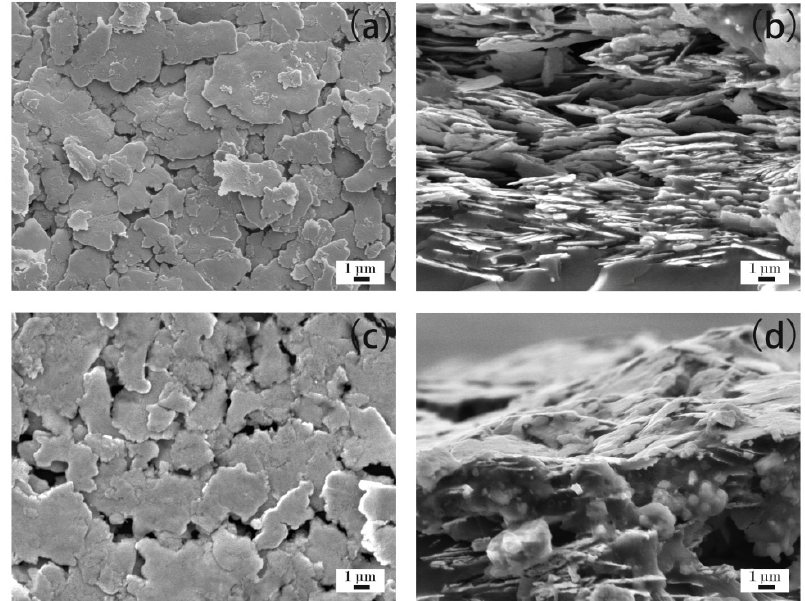
Figure 8. ECAs filled with 60 wt % Ag flakes. ( a ) ECAs fabricated by the powder spraying process; and ( b ) cross sections of ECAs fabricated by the powder spraying process; ( c ) ECAs fabricated by the conventional process; and ( d ) cross sections of ECAs fabricated by the conventional process.